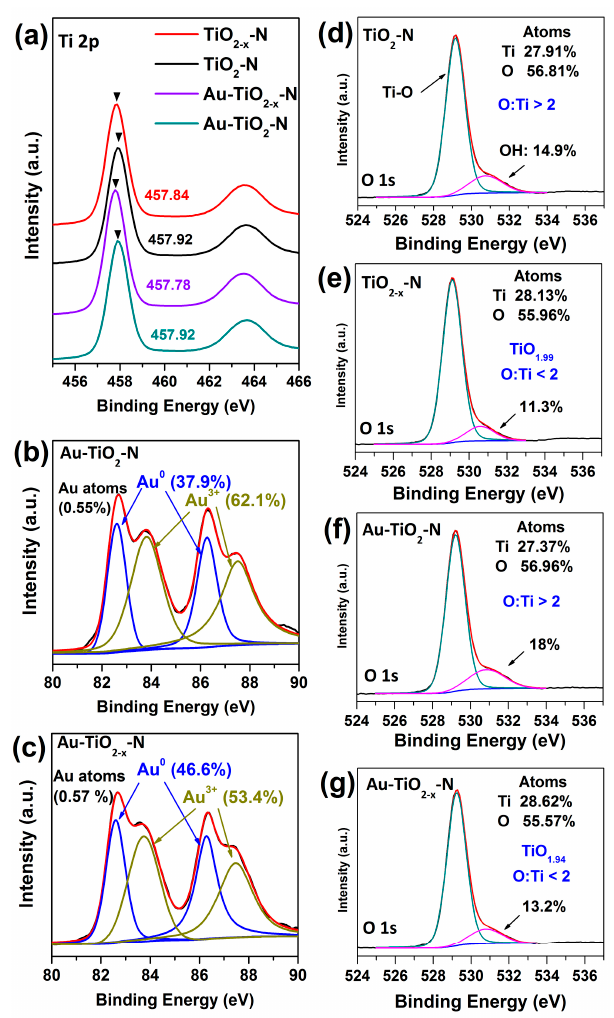
Figure 7. XPS spectra of various TiO 2 supports and Au ‐ TiO 2 catalysts ( a ) Ti 2p; ( b , c ) Au 4f; ( d – g ) O